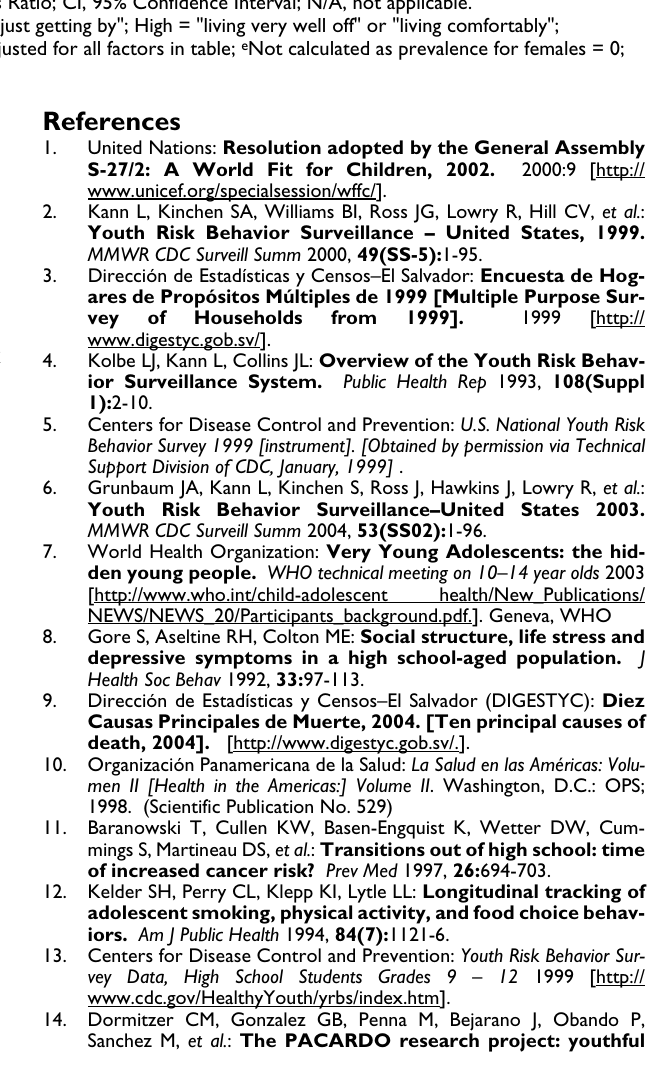
Had been pregnant or gotten intercourse someone